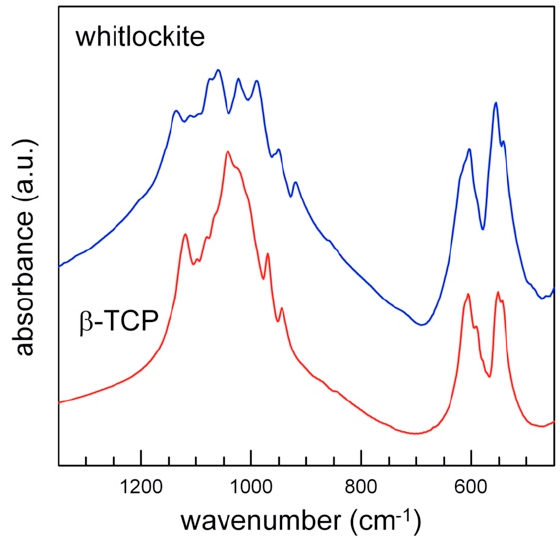
Figure 7. Powder FTIR spectra of whitlockite (blue) and TCP (red, sample from [11]): detail of the tetrahedral modes region (1600–400 cm − 1 ).